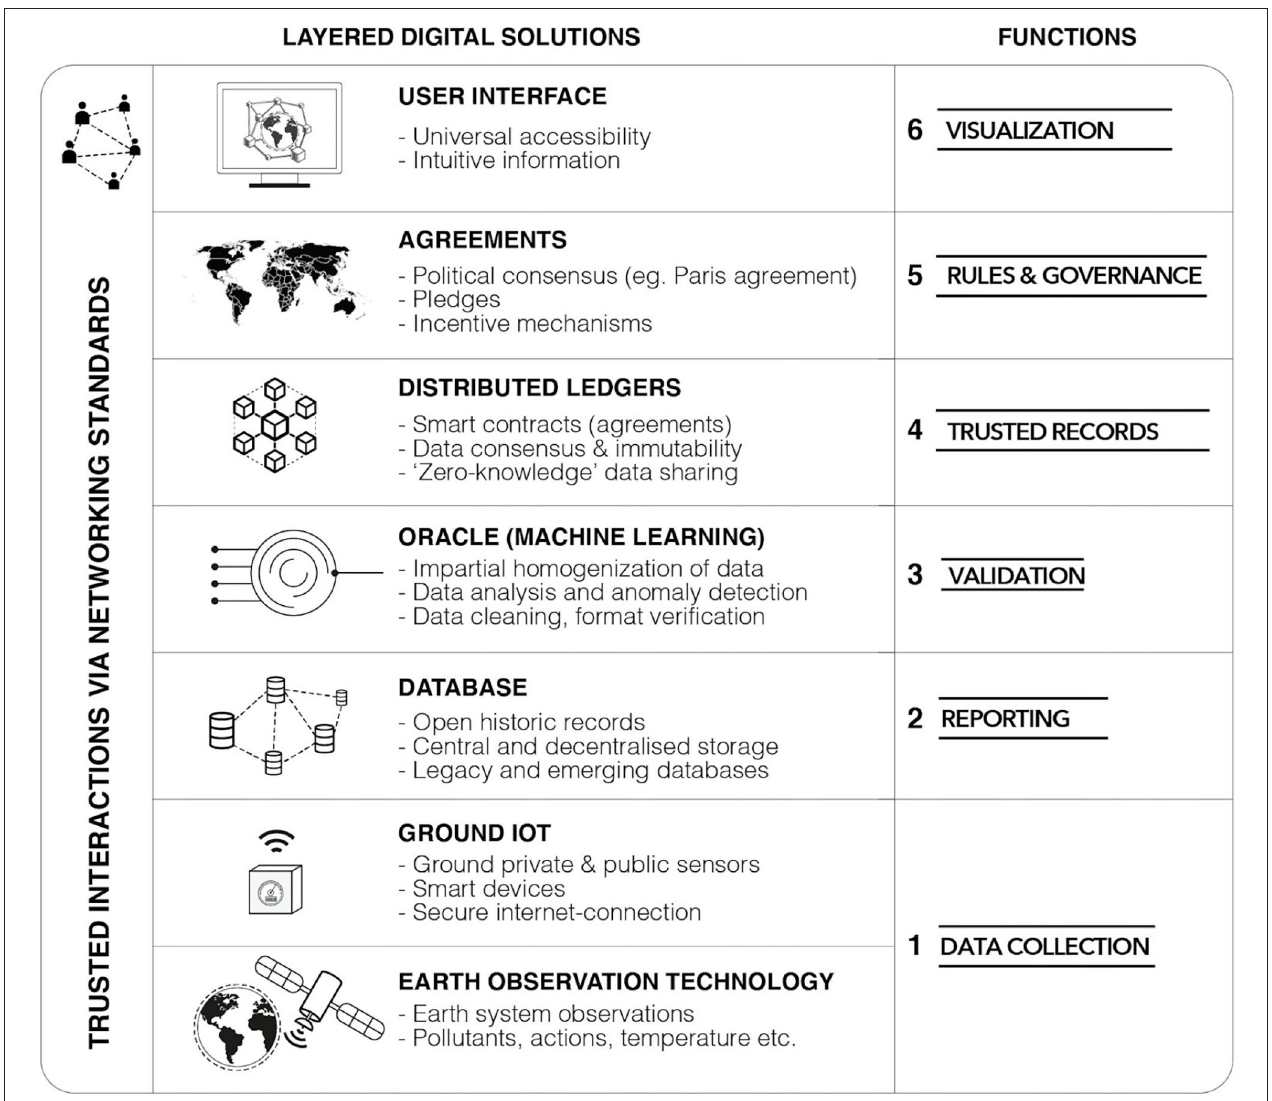
FIGURE 2 | Overview of different digital data collection technologies and layered data solutions within the climate sector. Source: